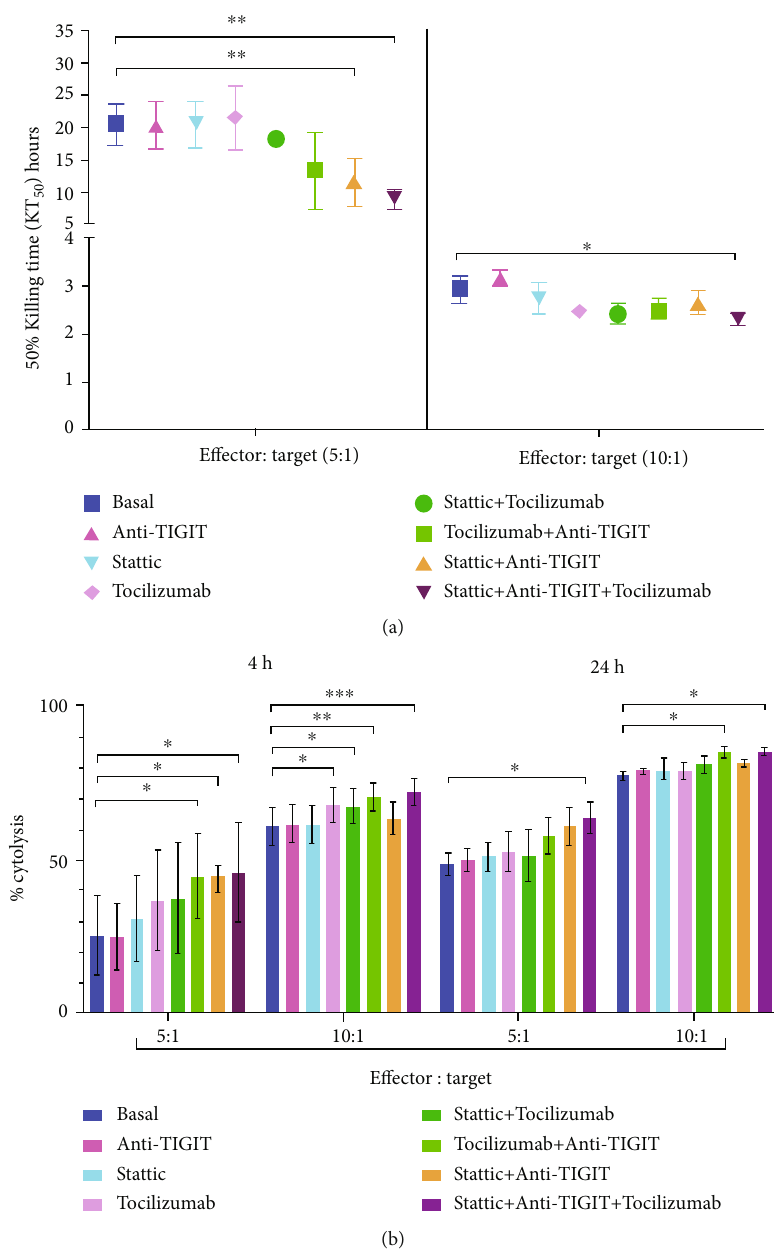
Figure 5: Stattic + Anti-TIGIT + Tocilizumab increase the cytotoxicity of NK-92 cells against DU145 prostate cancer cells. (a) Signi fi cant decrease in KT50 in the Stt + Anti-TIGIT + Tcz treated groups compared to the basal group. (b) A signi fi cant increase was observed in the percentage of cytolysis in the groups treated with Stt + Anti-TIGIT + Tcz compared with the basal group observed at 4 and 24 h of coculture in both ranges E : T. All experiments were repeated at least three times. Data are shown as the mean ± SD . ∗ p < 0 : 05 , ∗∗ p < 0 : 01 , ∗∗∗ p < 0 : 001 (ANOVA with Bonferroni multiple comparison test). Stt: stattic; Tcz: